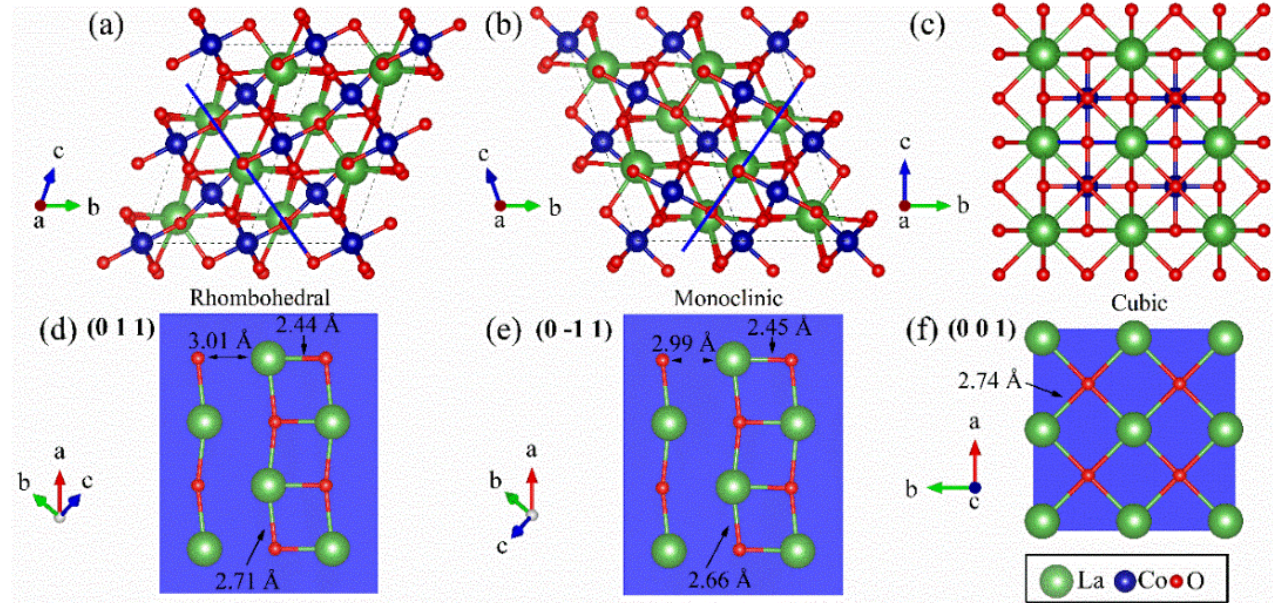
Figure 8. A 2 × 2 × 2 supercell of different models for the main phase of La 1 − x Ce x CoO 3 along the lattice vector a : ( a ) rhombohedral, ( b ) monoclinic, and ( c ) cubic. A solid blue line marks ( a ) a (011) plane of the rhombohedral lattice, ( b ) a (0-11) plane of the monoclinic lattice, and ( c ) a (001) plane of the cubic lattice. ( d – f ) Details of the corresponding plane marked in ( a – c ), respectively.